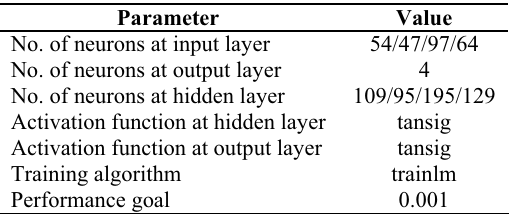
Table 4. The parameters of